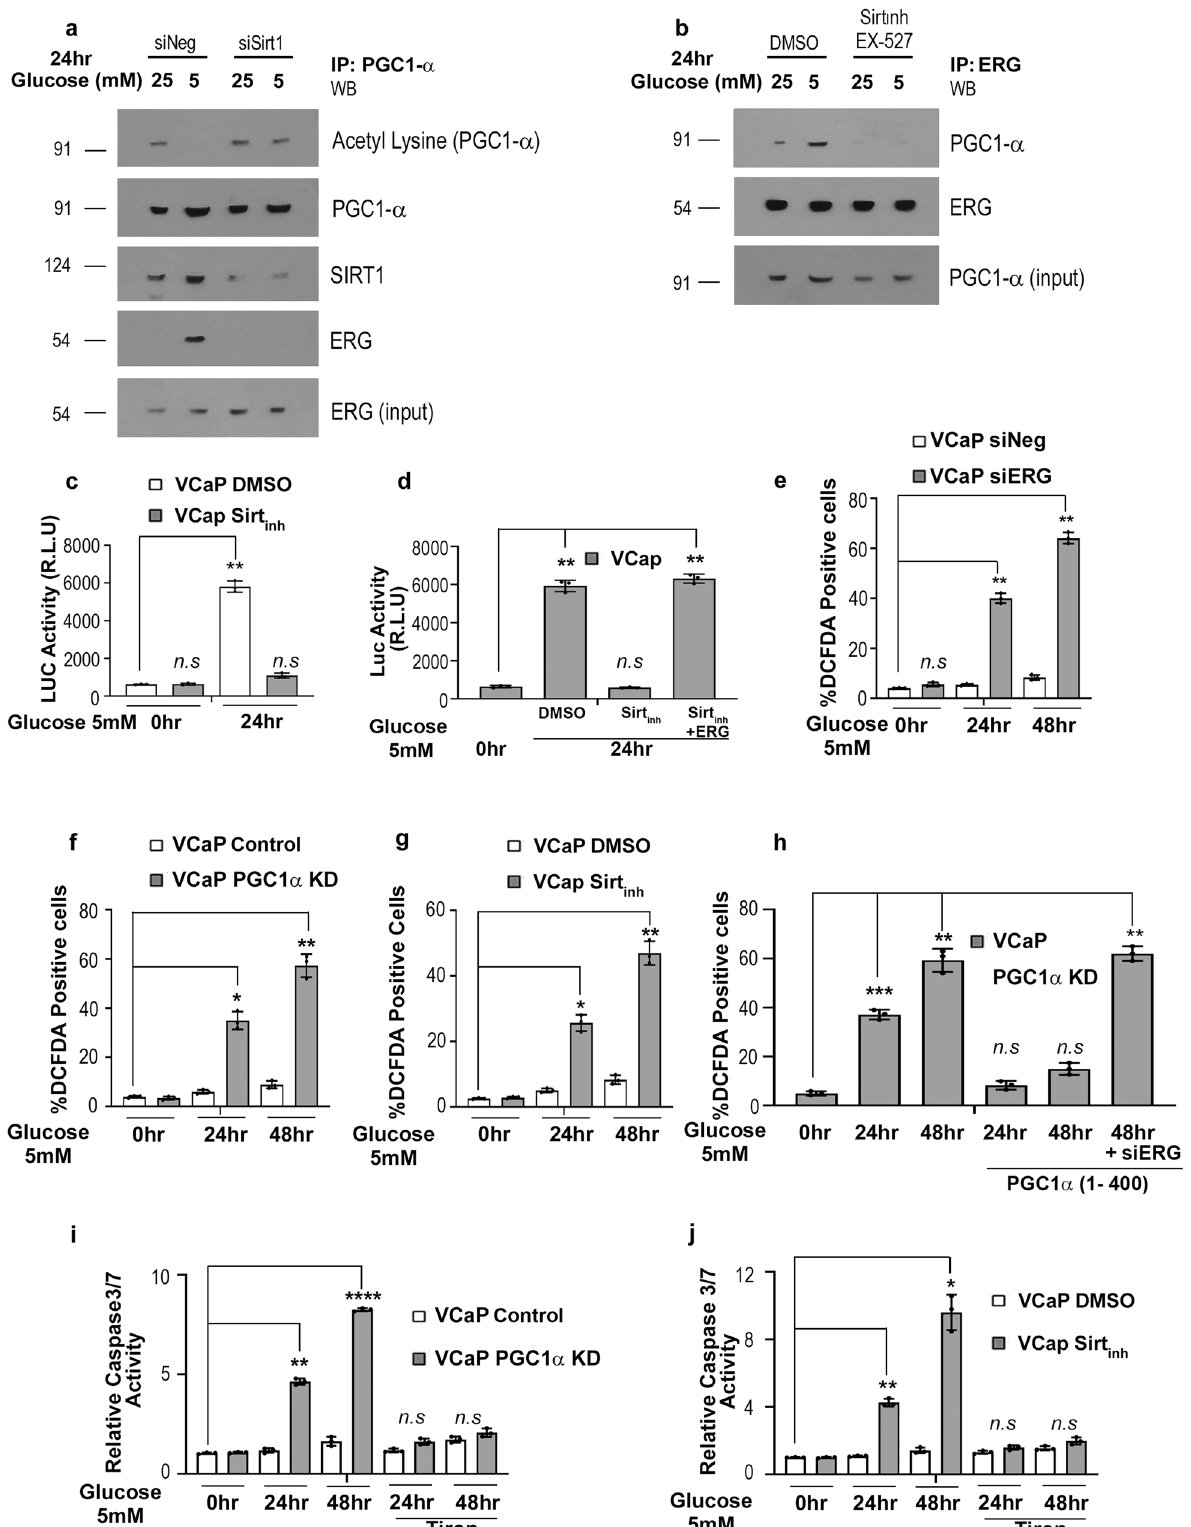
COLO320 cells during glucose stress (Fig. S4e). Under basal/ unstressed conditions, we did not observe any signi fi cant caspase activity associated with the silencing of these genes alone (Fig. S4f). To corroborate our fi nding in vivo, we used intermittent short-term fasting (STF) on PCa xenografts as described previously 45,46 . We had subjected SCID